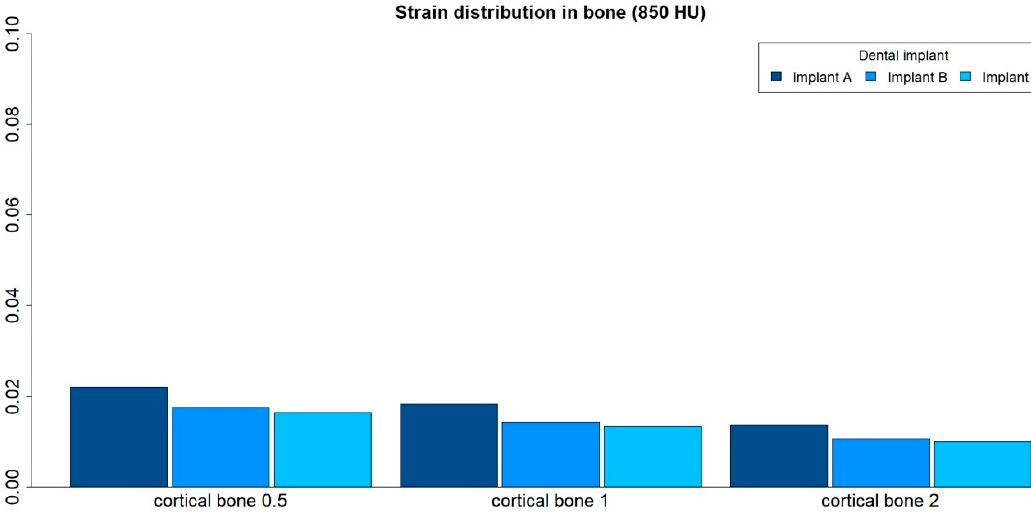
Figure 4. Strain distribution (mm) in high-density medullar bone (850 HU) for all cortical thicknesses (0.5 mm, 1 mm, and 2 mm) in all implant designs: A, B, and C. Table 2. Strain distribution (maximum absolute values, mm) in bone for both medullar bone densities and for all cortical thicknesses (0.5 mm, 1 mm, and 2 mm) in all implant types: A, B, and C.